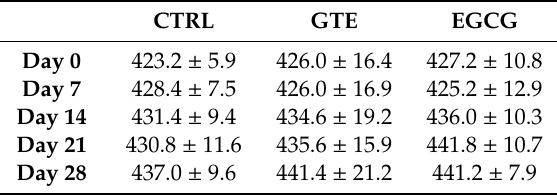
Table 1. Body weights (g). Mean values ± standard error of the mean (SEM) of body weights measured once a week, in controls (CTRL) and green tea extract (GTE)- and epigallocatechin-3-gallate (EGCG)- supplemented